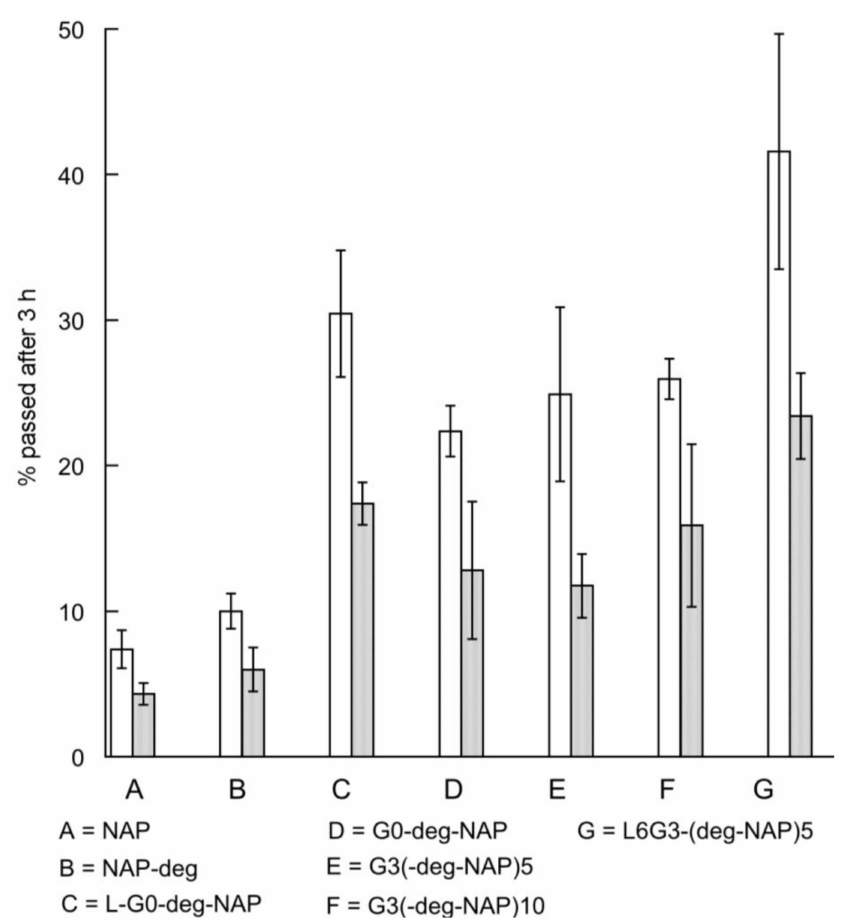
Figure 7. The A-B ( (cid:3) ) and B-A ( (cid:4) ) transport of naproxen across Caco-2 cell monolayers for naproxen and conjugates (each equivalent to 100 µ M naproxen) after 3 h of incubation (mean ± S.D., n =